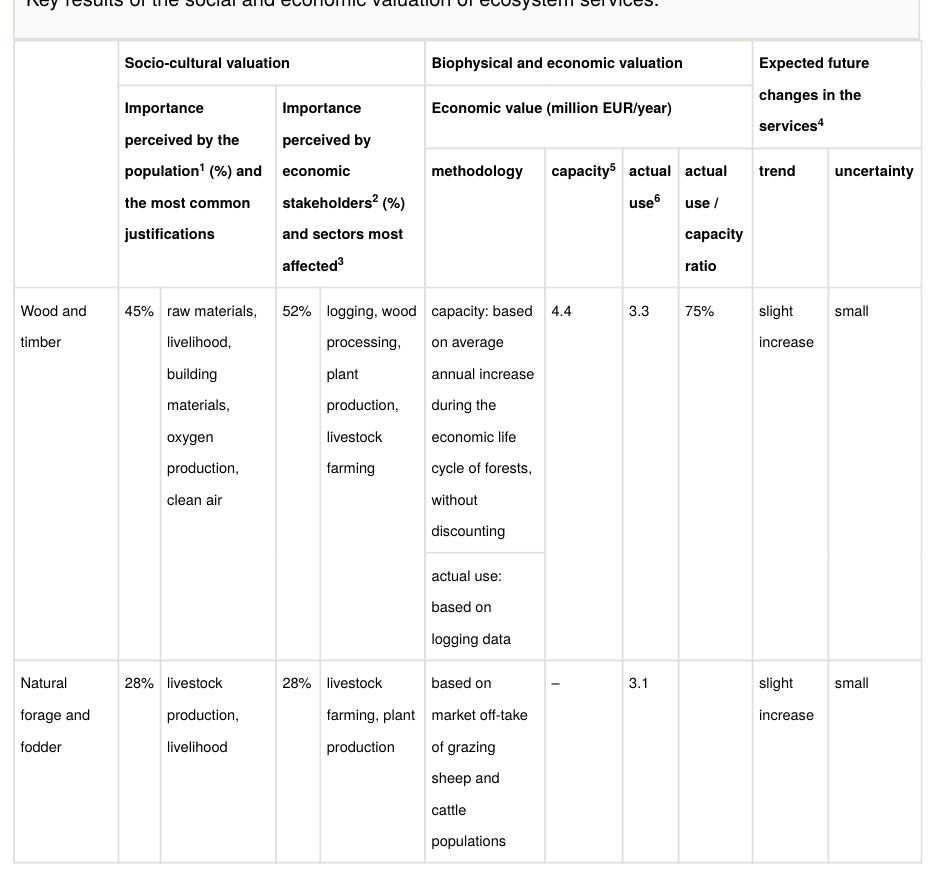
Key results of the social and economic valuation of ecosystem